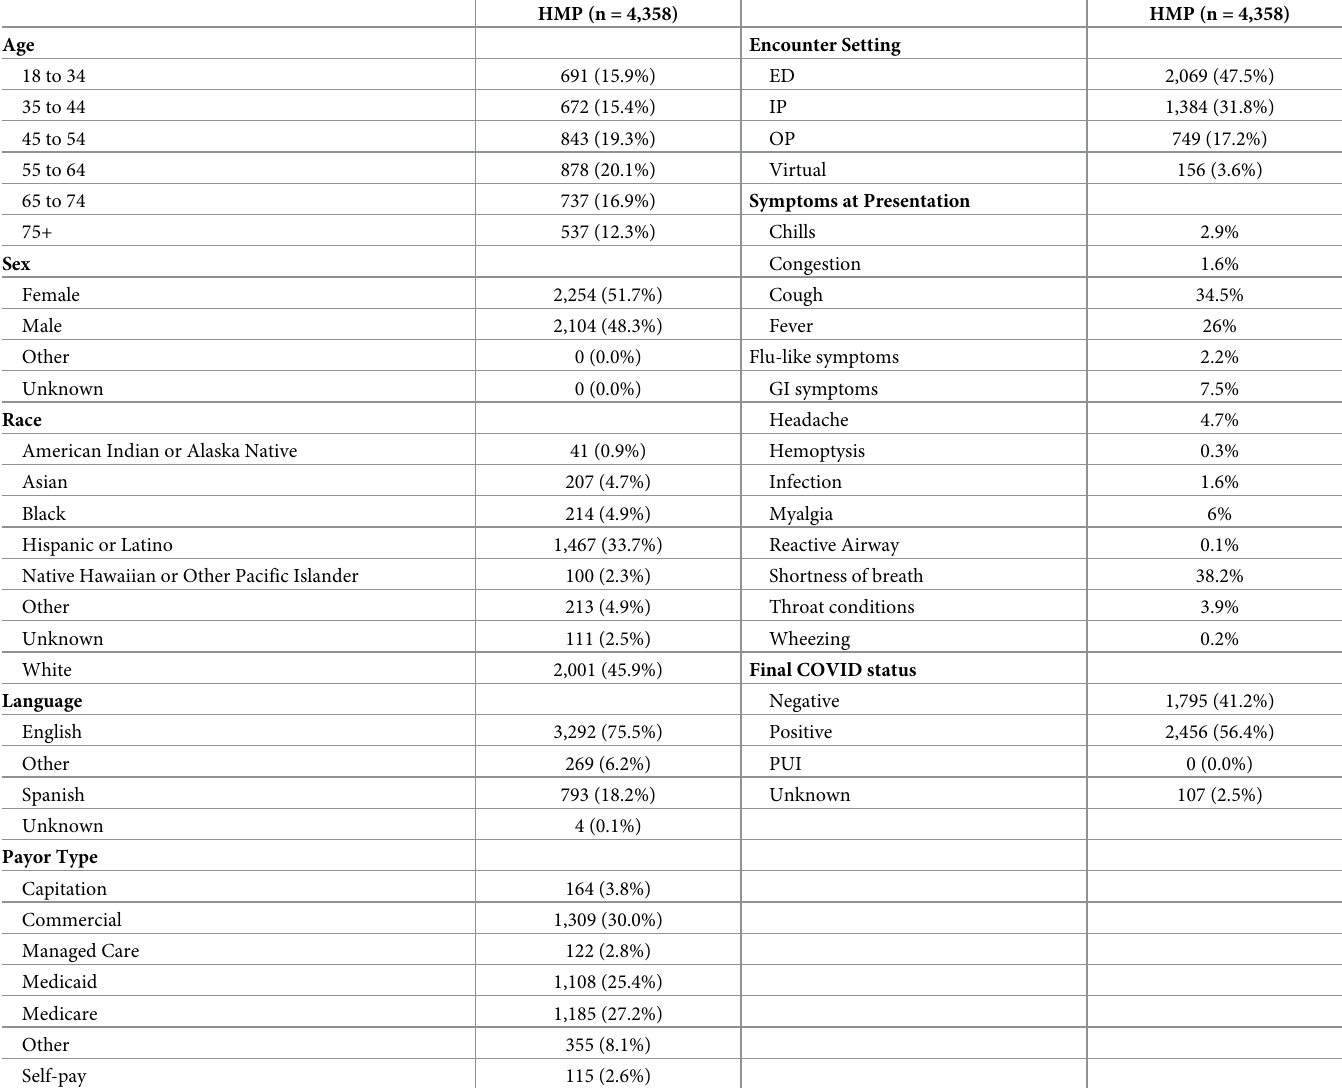
Table 1. Home monitoring program participant